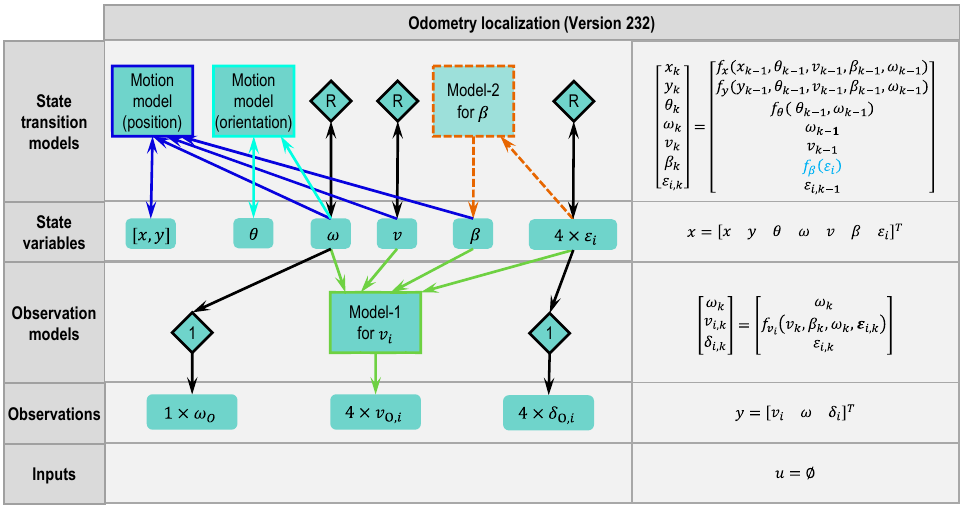
Figure 11. Modular approach to designing a state estimator for odometry localization (Version 232 based on Version 212, changes marked with dashed lines or dashed blocks and blue letters, respec- tively).